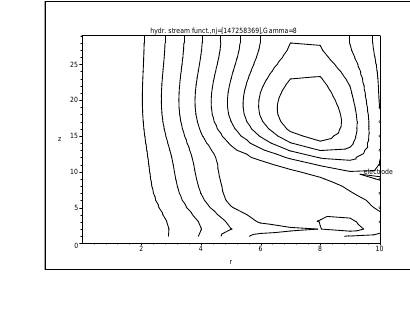
Figure 6. The stream functions for nj = [147258369] , ψ ∈ (0 . 00 , 0 . 29) , Γ = 8